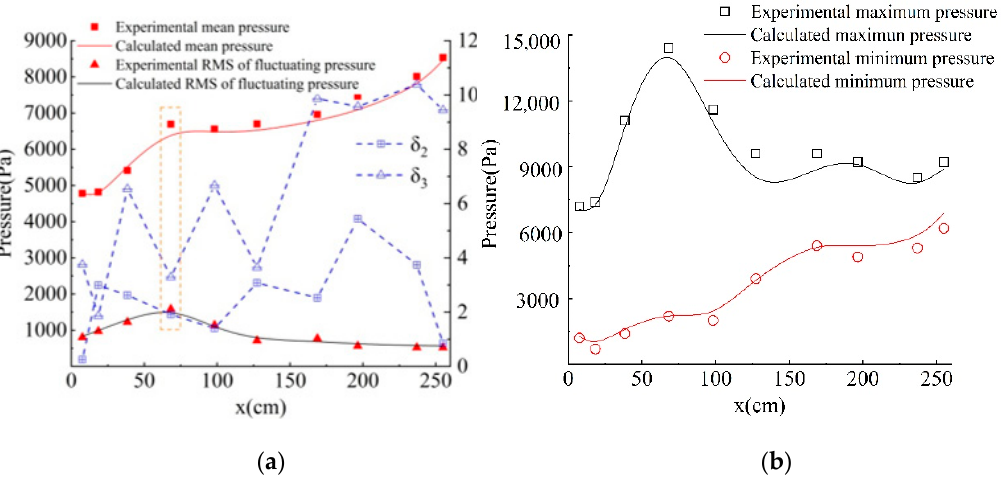
Figure 8. Comparison of pressure at 10 pressure measurement points: ( a ) Comparison of root mean square (RMS) of fluctuating and time-average pressure; ( b ) Comparison of maximum and minimum pressure.